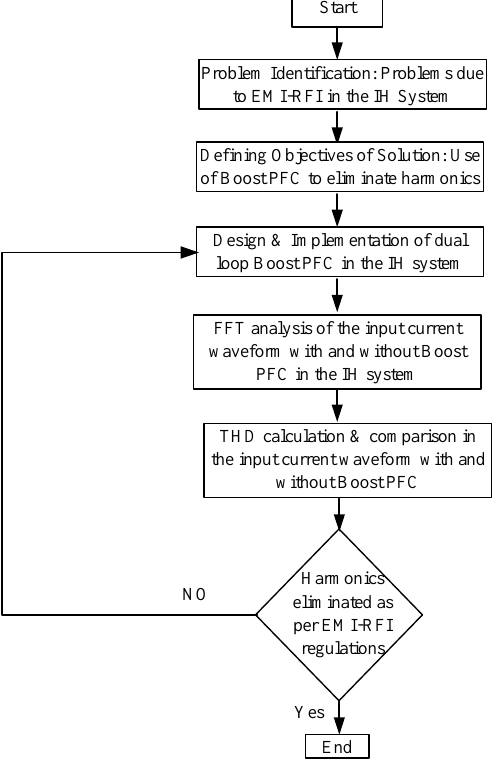
Figure 1. Flow chart showing the research methodology of IH system with Boost